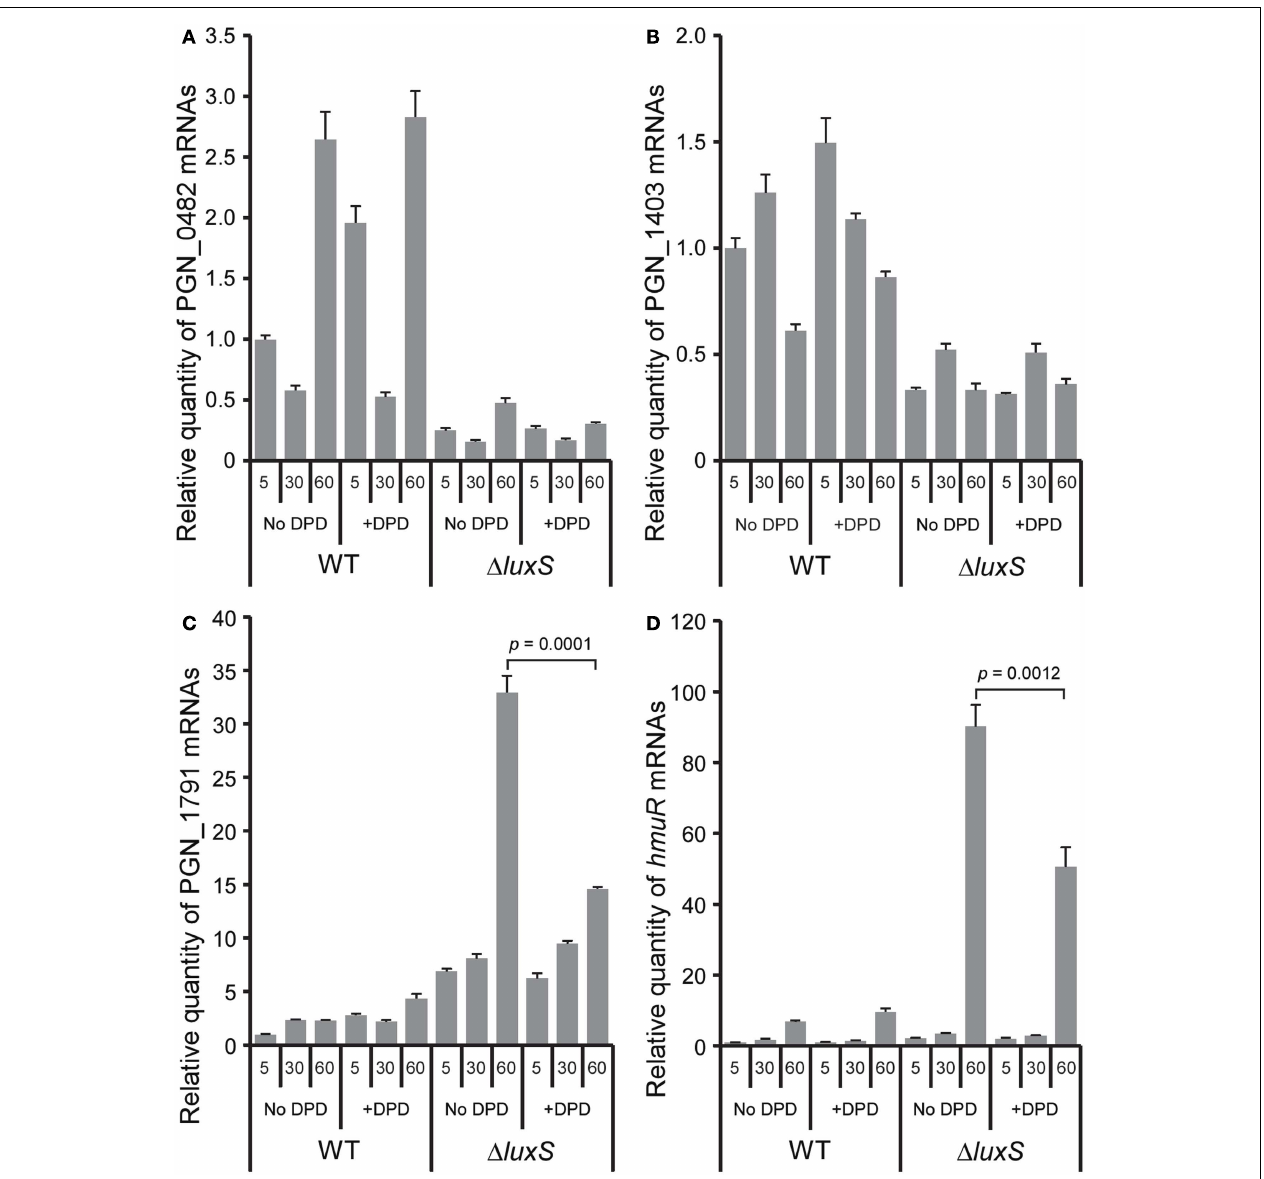
qRT-PCR following incubation with 4 µ M of synthetic DPD for the indicated times. Results are representative of three independent assays. p -values were calculated by unpaired t -test. Error bars represent standard deviations ( n =